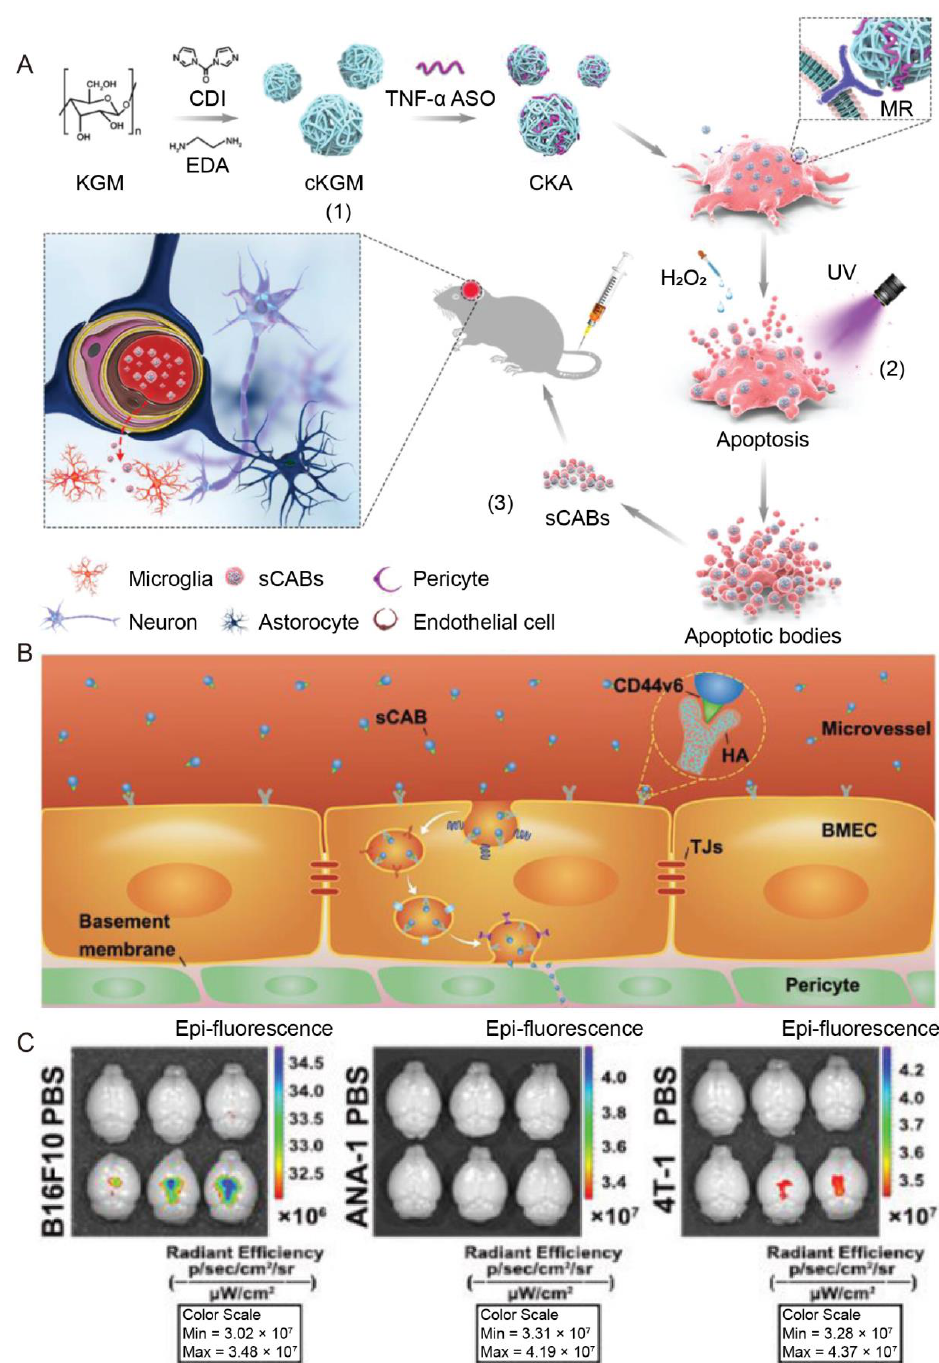
Figure 7. Tumor-derived EVs delivered therapeutic cargo for Parkinson’s disease treatment. ( A ) Schematic diagram of producing small apoptotic bodies (sCABs) loaded with ASO for brain pene-